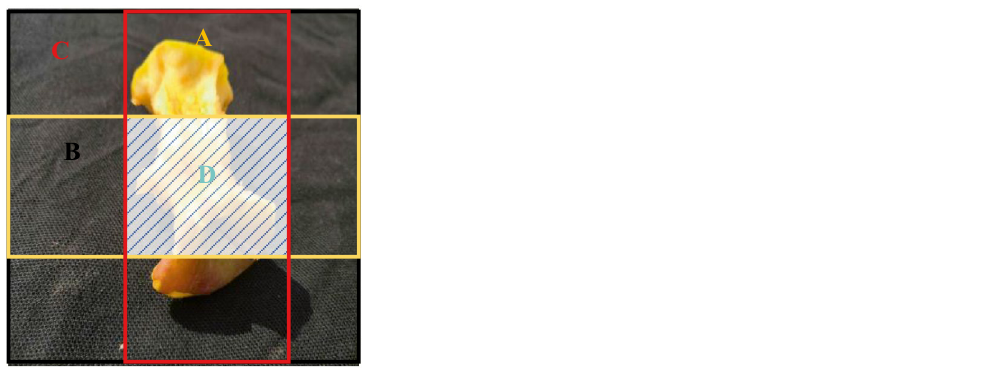
Figure 7. GIoU evaluation